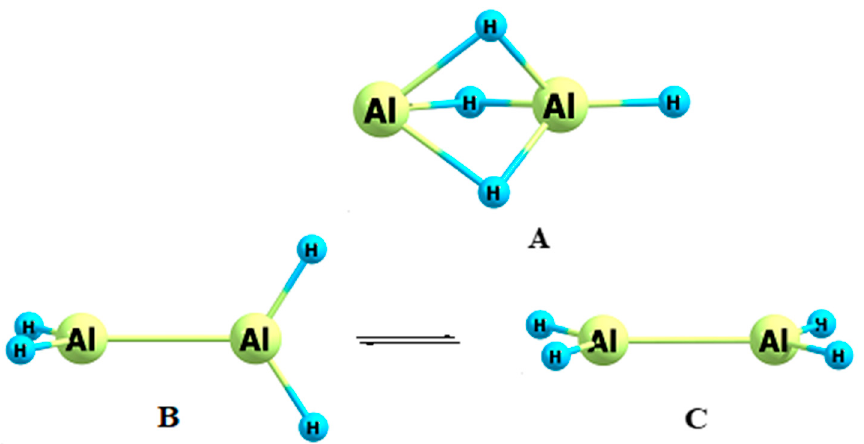
Figure 9. Forms of dialane, Al 2 H 4 . Adapted with modification [178].